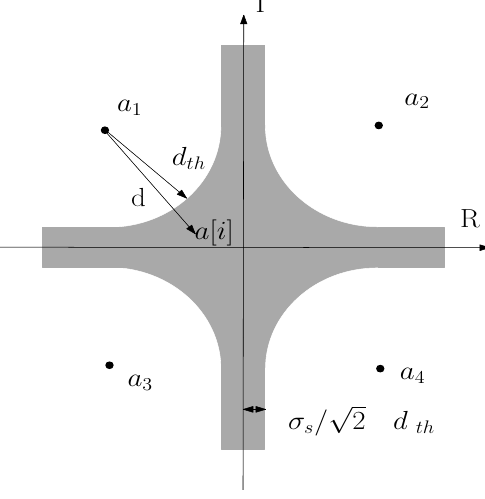
Figure 1. Constellation constraints structure. a i is the coordinate point on the constellation. Shaded areas is unreliable area, and bright areas is reliable area. Value d th is the CC radius and d denotes the distance between the estimated symbol and its nearest